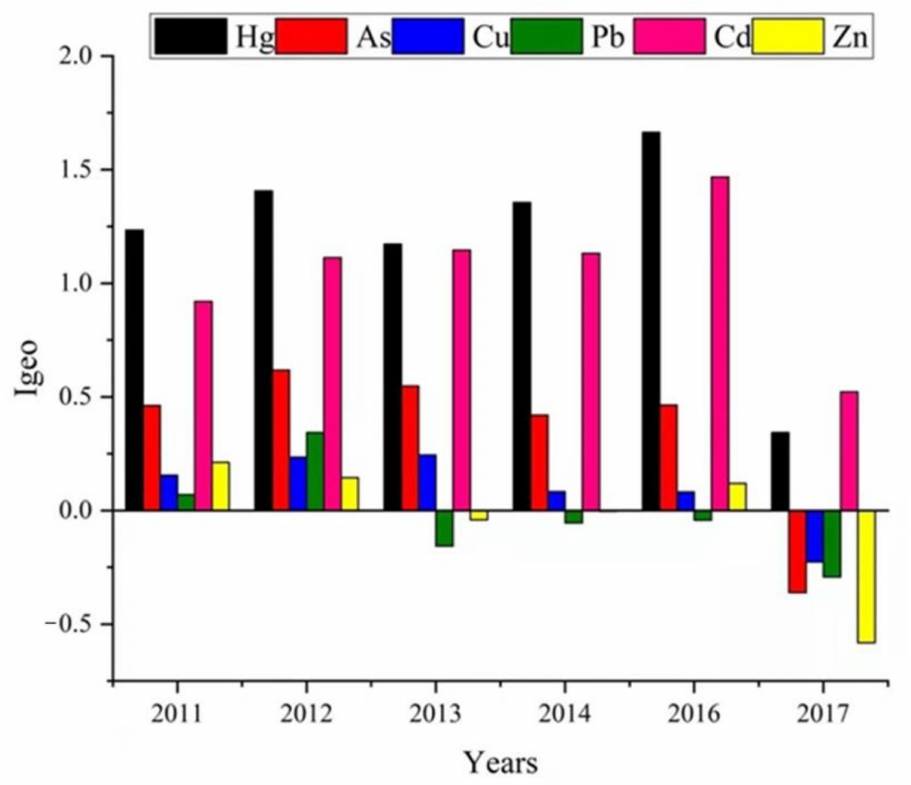
Figure 5. The I geo values of HMs in different